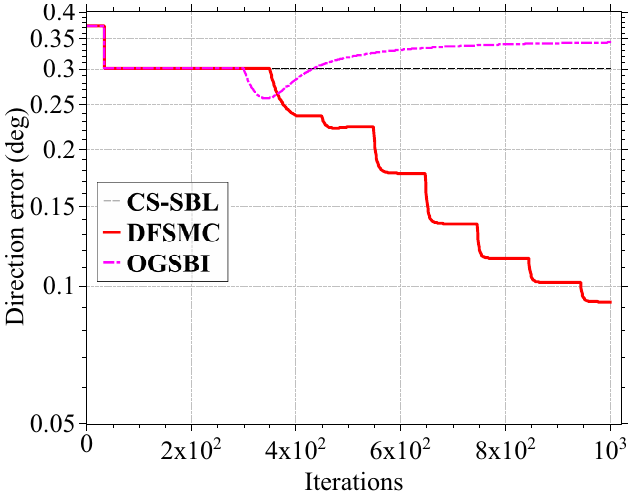
Figure 5. The spatial spectrum for direction estimation ( α c = − 8 dB).